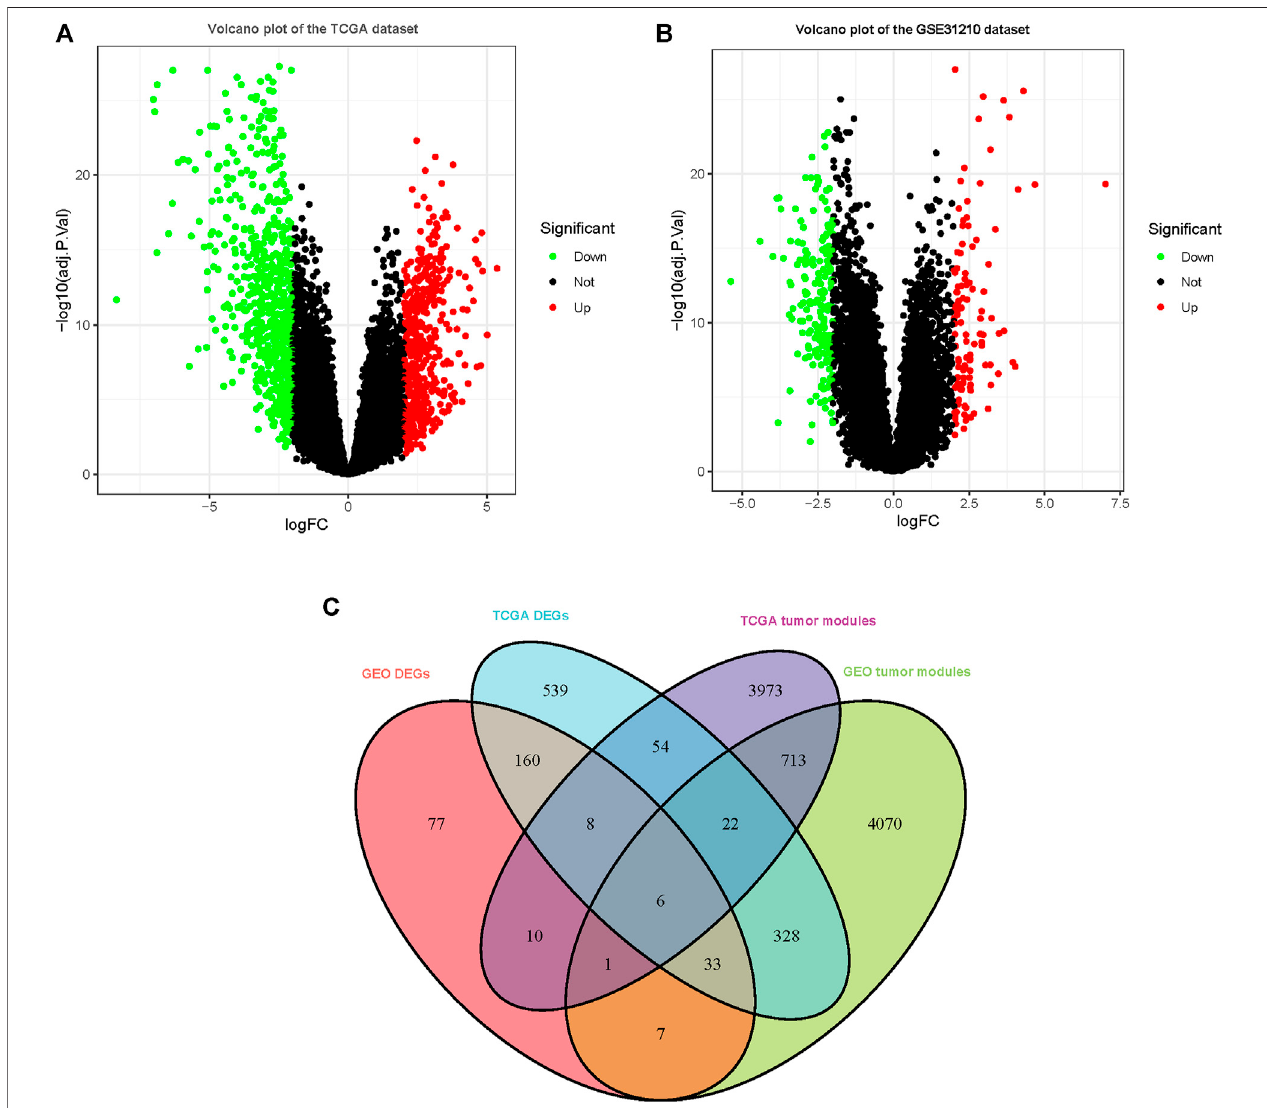
FIGURE 2 | DEGs were observed in TCGA and GSE31210 datasets using |logFC| ≥ 2.0 and adj. p < 0.05 as cutoff parameters. (A) Volcano plot of DEGs in TCGA dataset. (B) Volcano plot of DEGs in the GSE31210 dataset. (C) Genes contained in DEGs and tumor-related modules in a Venn diagram. At the intersection of DEGs and modules, there are a total of 6 overlapping